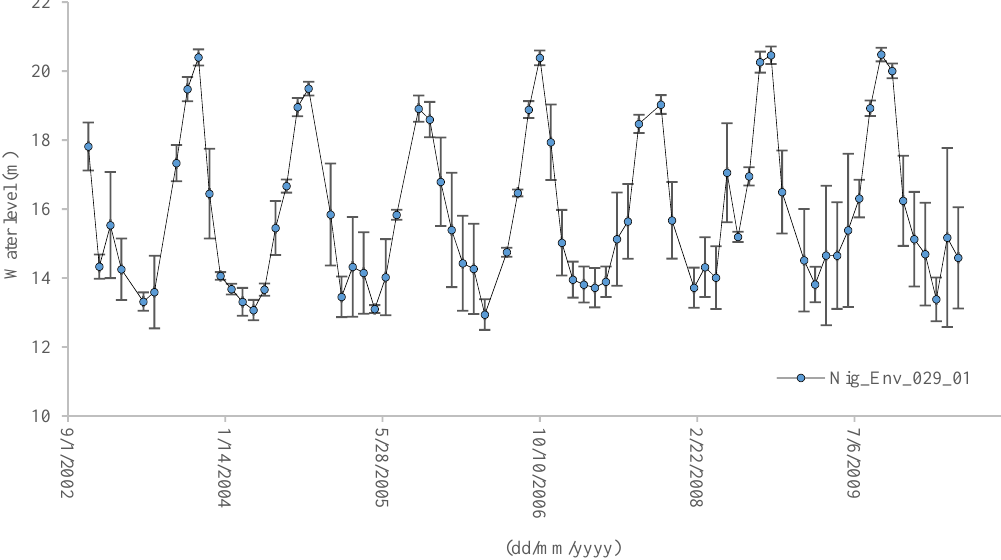
Figure 3. Typical water level time-series extracted from an altimetry virtual station along the river Niger (error bars indicate standard deviation from water level height (m), and are low during peak flooding, as altimetry measurement accuracy is improved during this season [42].